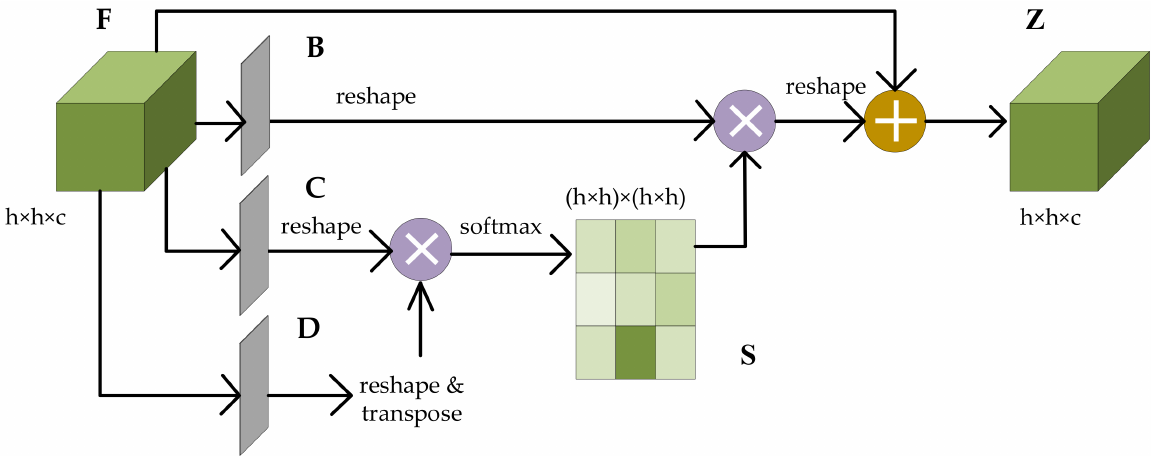
Figure 3. The schematic diagram of the spatial attention